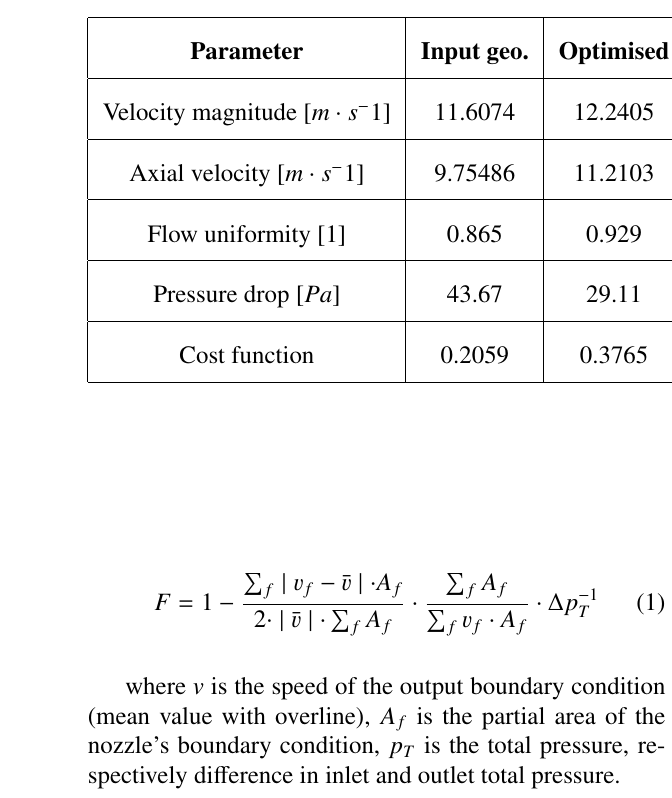
Table 1. Design comparison - monitored parameters .